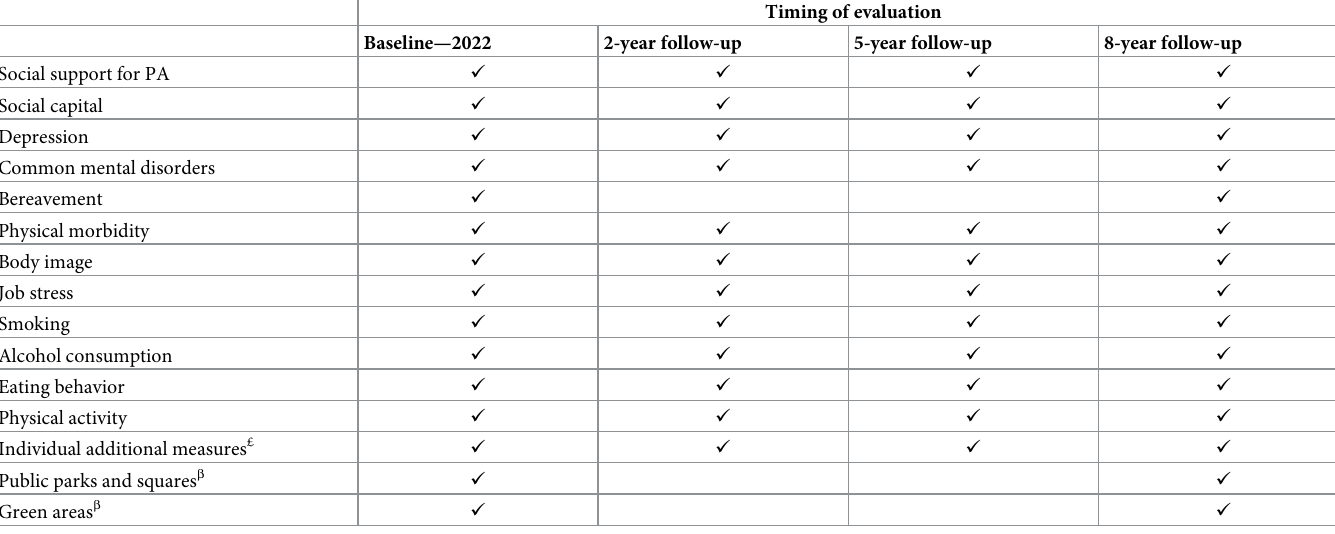
Table 1. Description of information include according to each ELDAF